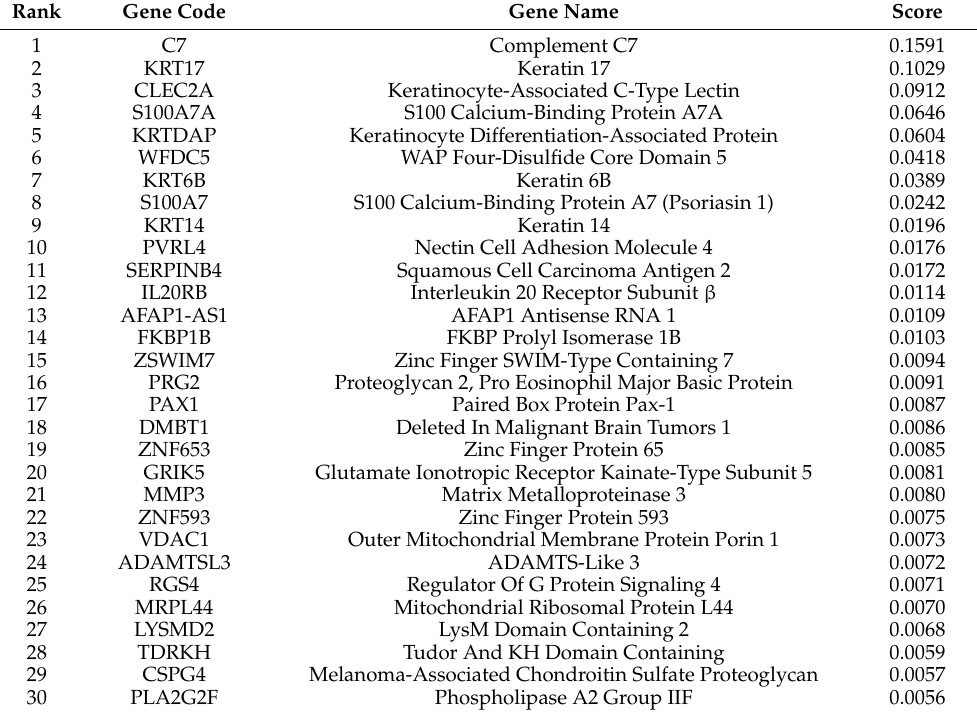
Table 1. The 30 genes exhibiting the highest scores through random forest for biomarker discovery